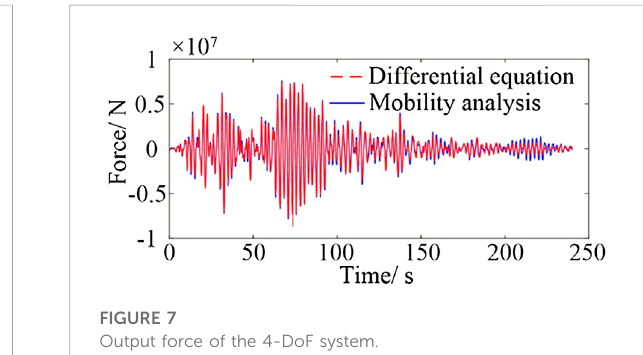
FIGURE 7 Output force of the 4-DoF